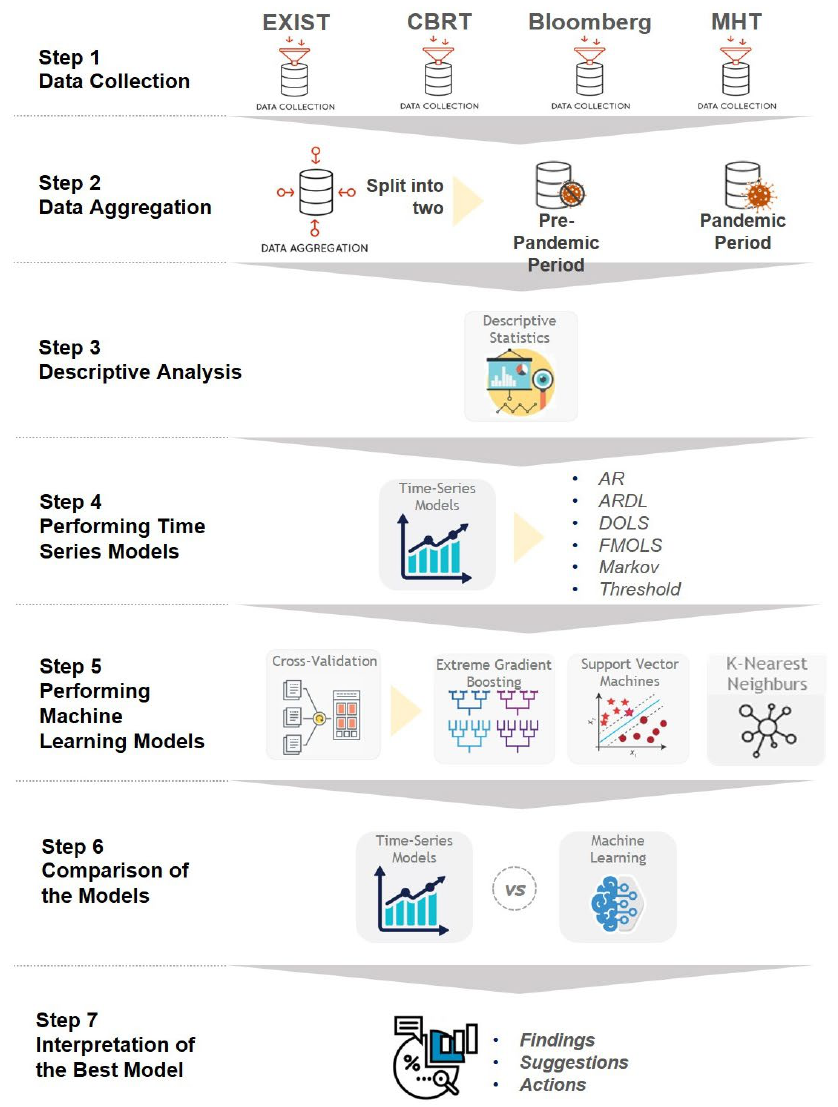
Figure 1. The methodology flowchart.